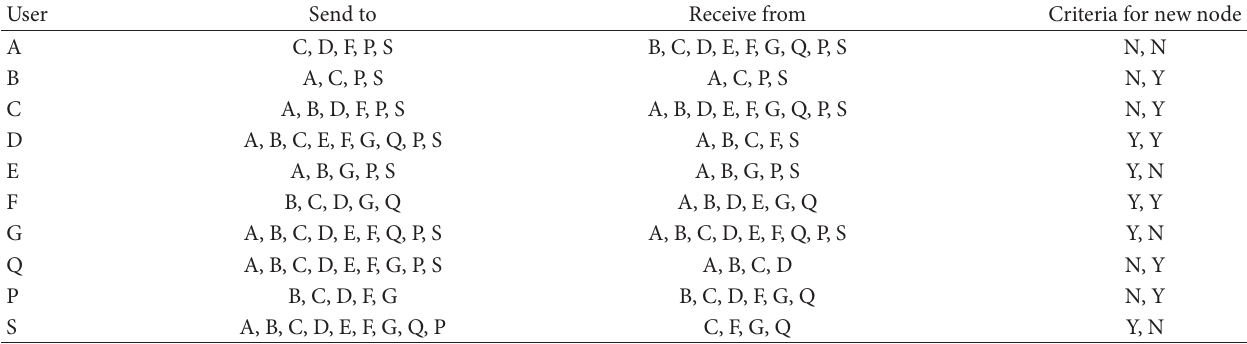
Table 1: User’s preferences.